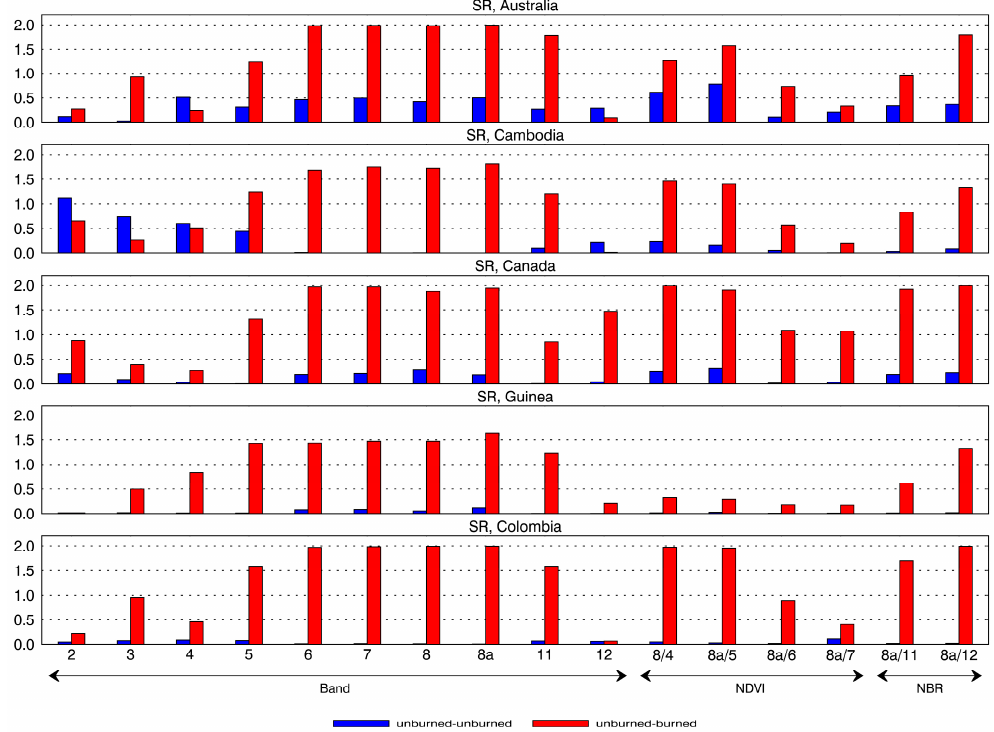
Figure 5. Transformed divergence (TD) separability values as Figure 4 but derived from the surface reflectance data (i.e., from the SEN2COR atmospherically corrected data).